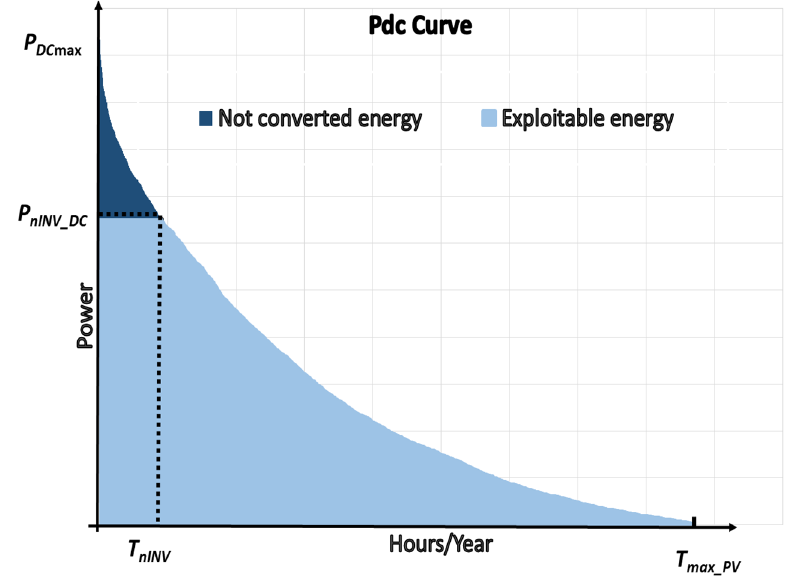
Figure 5. Illustration of the efficiency evaluation curve of Case B: the area above P nINV_DC represents the energy not exploited, since the corresponding power values are greater than the inverter rated